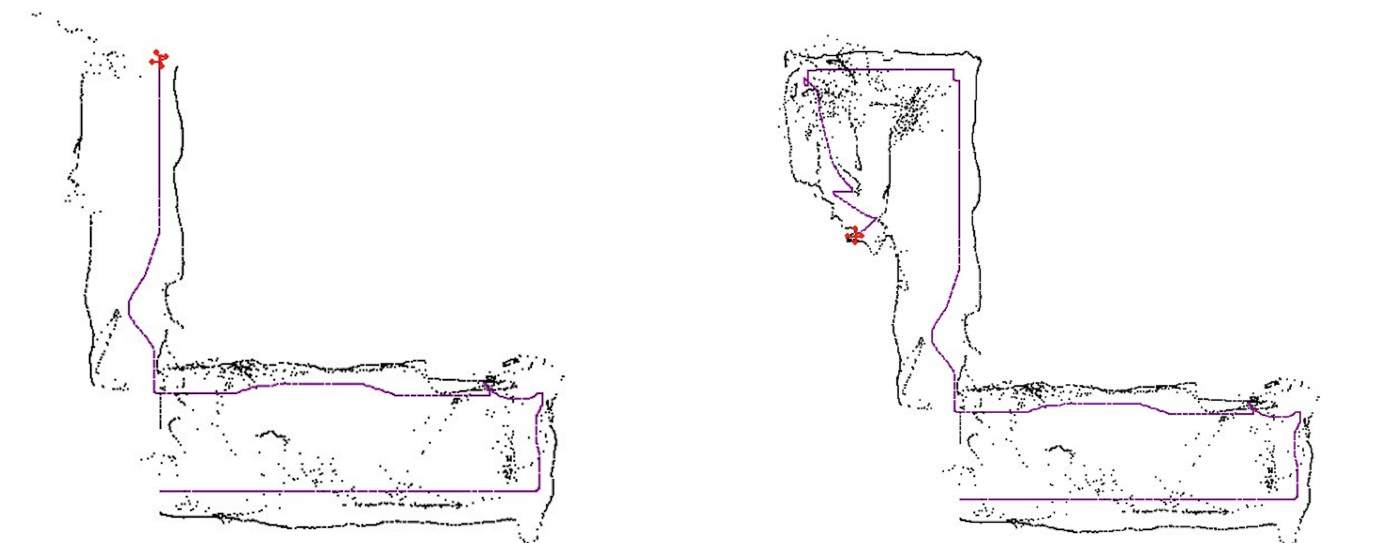
Figure 8. BAT flying up stairs.